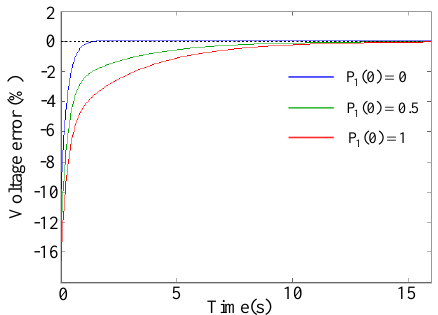
Figure 4. Voltage step responses of a nonlinear function.